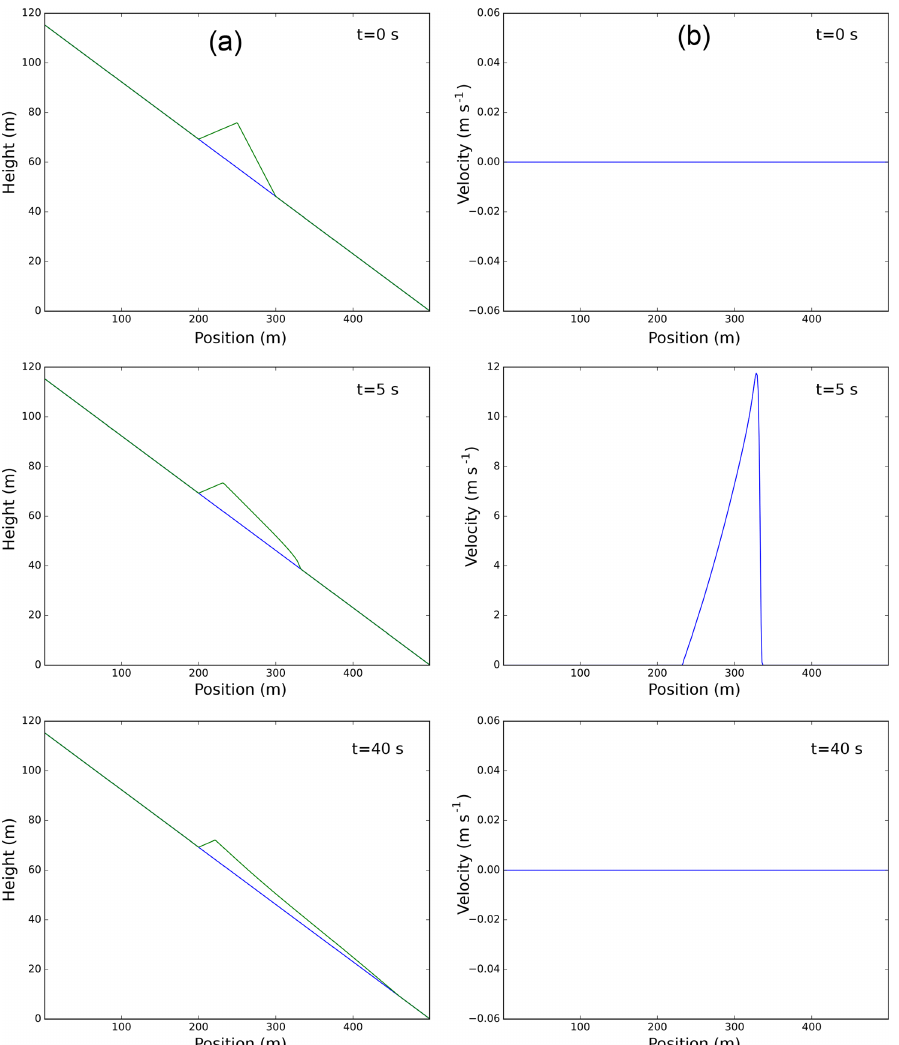
Figure 4. Numerical solution of a 1-D problem with Voellmy–Salm friction at three different times. In (a) the topography (blue line) and the profile of the material (green line) are plotted. In (b) the corresponding velocities are shown.